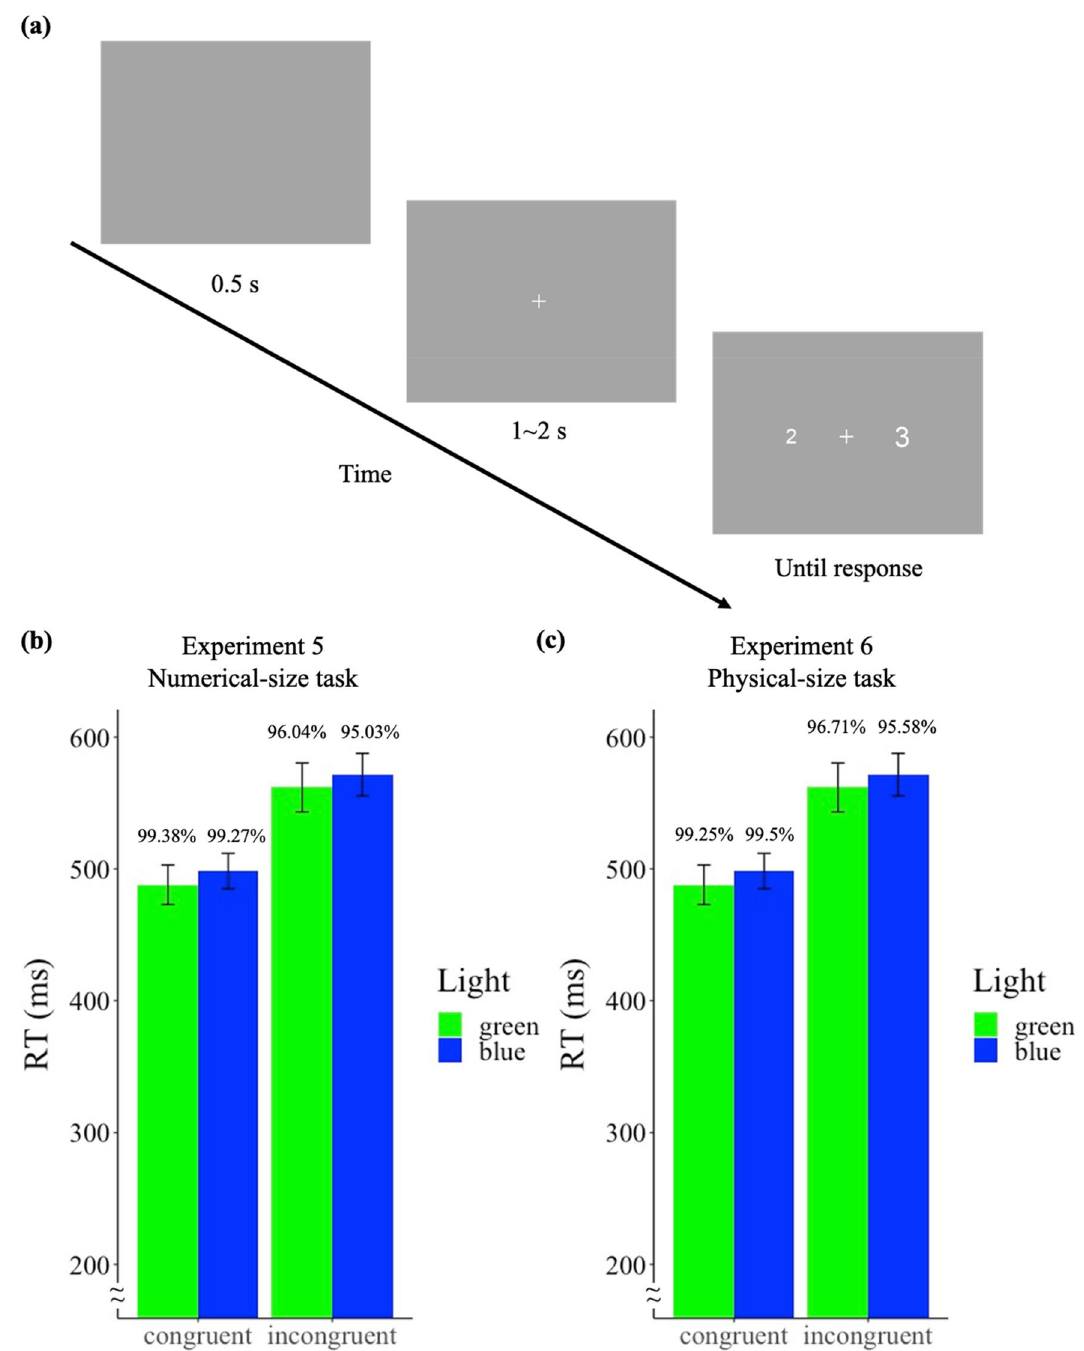
Figure 5. ( a ) The experimental design of Study 3 (note the displays are not to scale). ( b ) Reaction time in congruent and incongruent trials across green and blue light conditions in Experiment 5 (numerical-size task). ( c ) Reaction time in congruent and incongruent trials across green and blue light conditions in Experiment 6 (physical-size task). The number shown above each bar denotes the accuracy of each condition. Error bars represent one